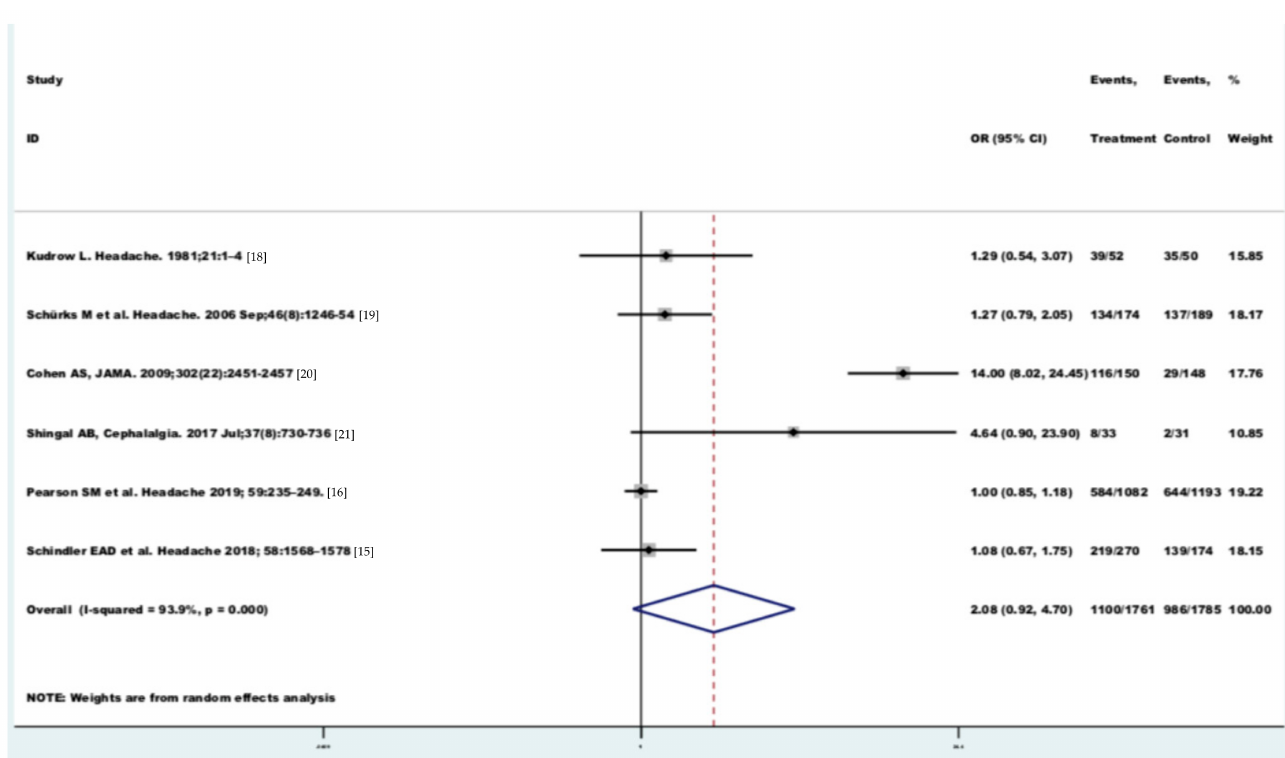
Figure 2. Forest plot of the pooled odds ratio (OR) of migraine in the oxygen therapy group compared to the placebo group, ( p = 0.000). I 2 = I-squared (variation in OR attributable to heterogeneity) =